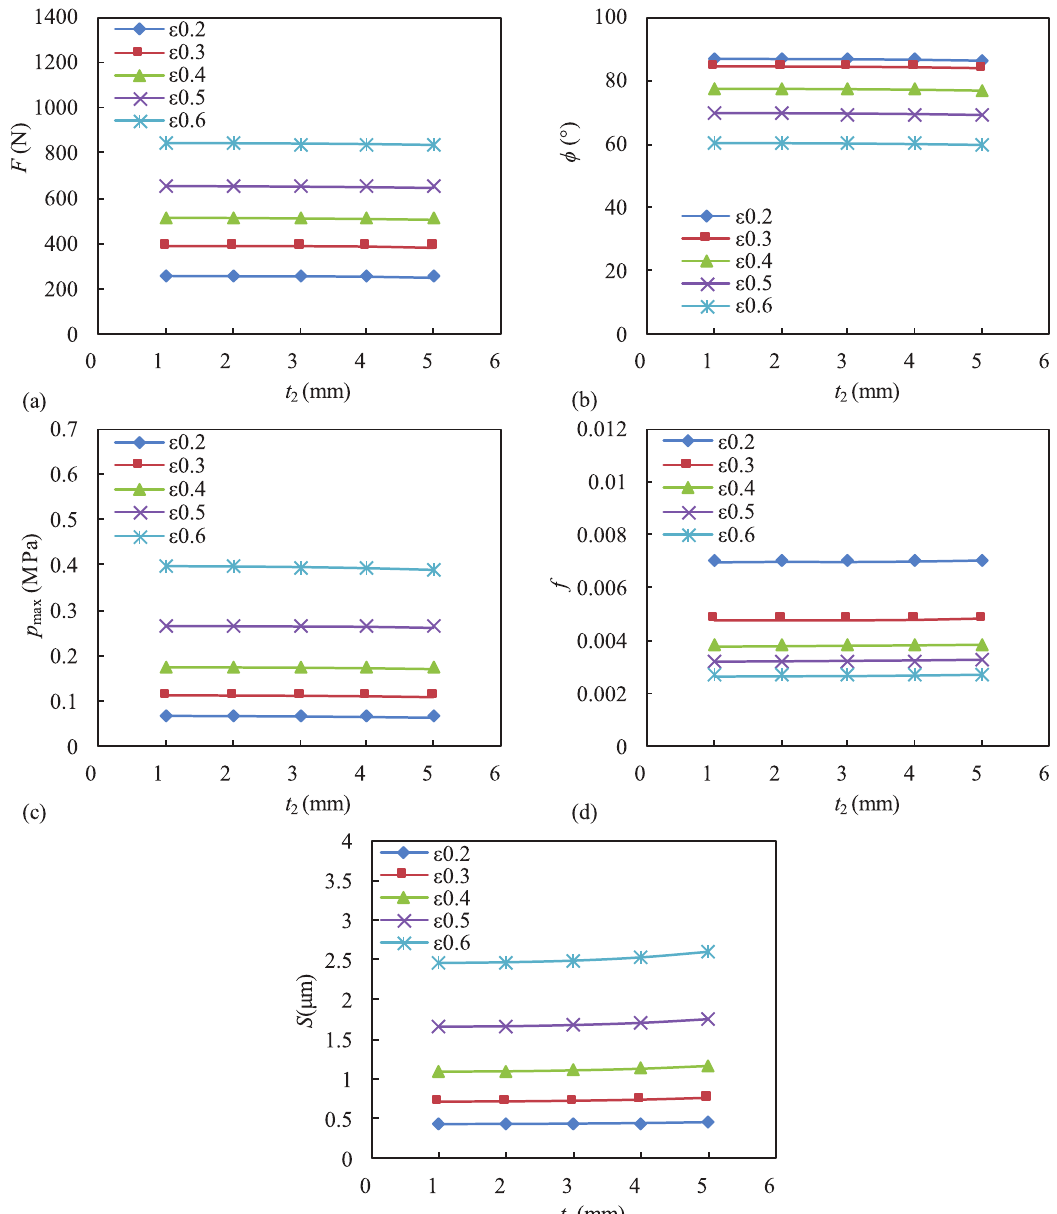
Fig. 15. Effect of low elastic under-layer bush thickness on the lubrication performance of double-layer bearing (a) Load carrying capacity, (b) Attitude angle, (c) Maximum water fi lm pressure, (d) Friction coef fi cient, (e) Maximum bearing bush deformation, for N = 1500 rpm, E1 = 1000 MPa, E2 = 400 MPa, n1 = 0.4, n2 =